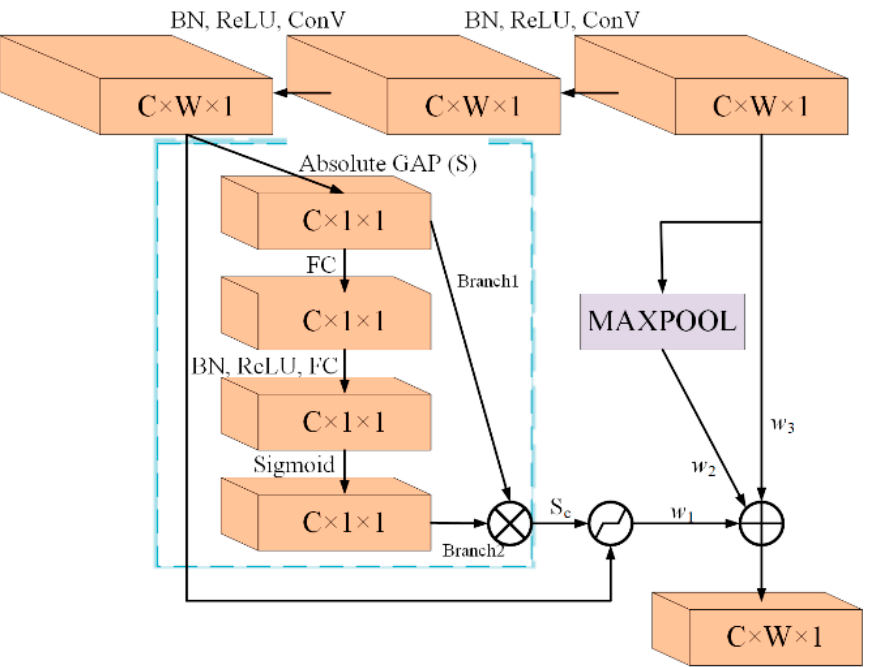
Figure 1. AMC-RSB, where the blue dotted line frame is the channel attention mechanism